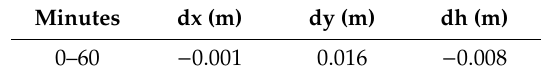
Table 15. 60 min session positioning results summary, baseline OPNT–P30Pro (4 km).